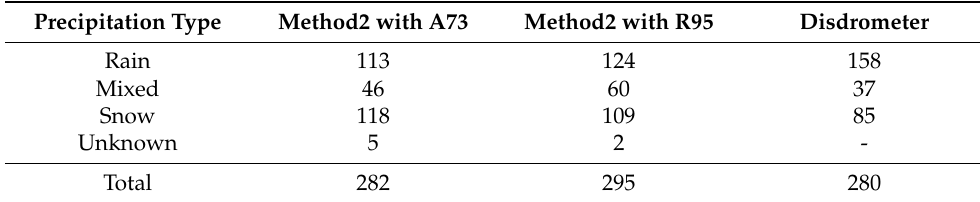
Table 5. Number of each precipitation type cases for Method2 (A73 and R95) and disdrometer observations after the 5-min time resolution re-binning.